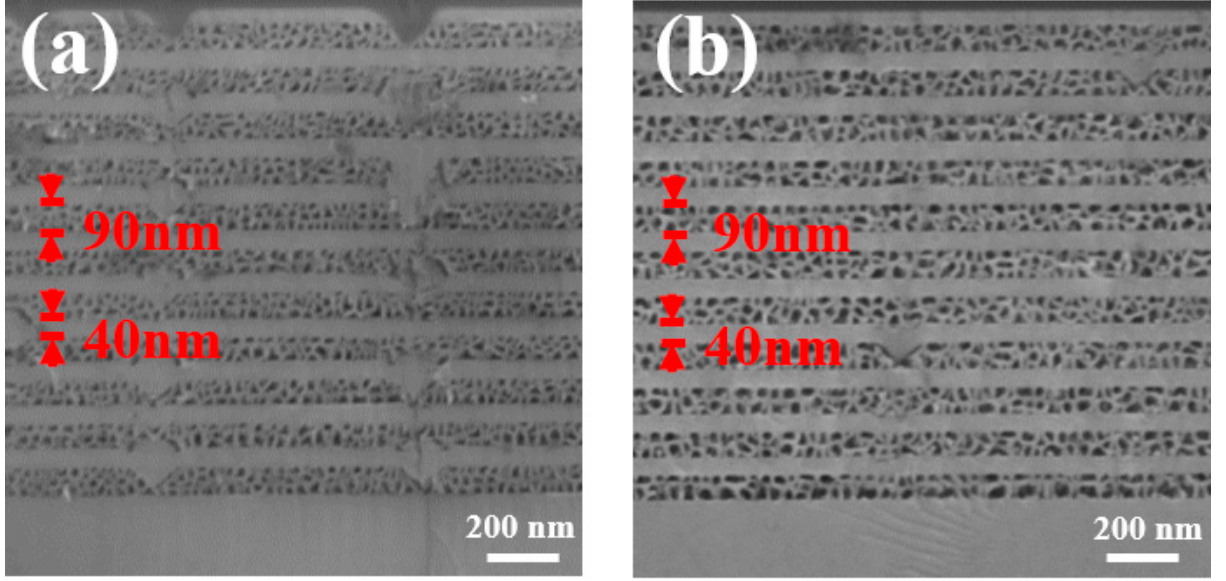
Figure 3. Cross ‐ sectional SEM images of ( a ) Sample A and ( b ) Sample B after EC etching. Figure 3. Cross-sectional SEM images of ( a ) Sample A and ( b ) Sample B after EC The effective index of the NP ‐ (Al)GaN can be estimated from the volume average theory (VAT)